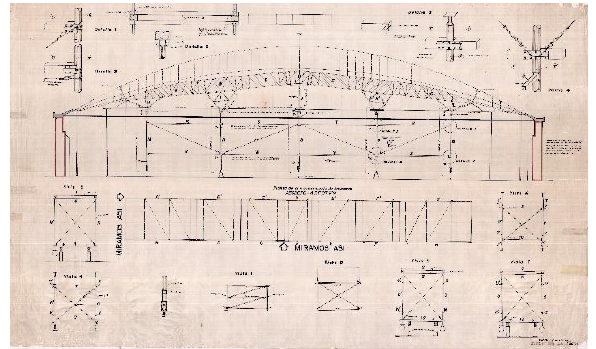
Figure 6: Example of Eladio Dieste’s Seaport Deposit of Montevideo’s original construction drawing sheet obtained during the research. This specific sheet establishes the formwork for the construction of the Roof Surface. © Dieste & Montañez / Udelar